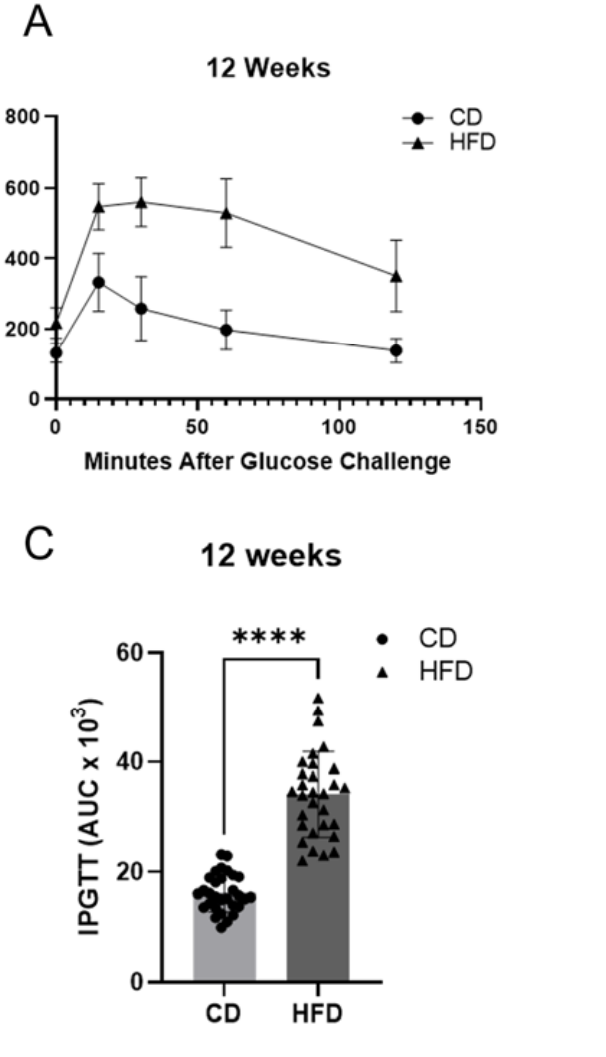
Figure 4. Effects of HFD and zinc supplementation on glucose tolerance. HFD induced increase in glucose tolerance was unaffected by zinc supplementation. Blood glucose levels in CD and HFD groups after IPGTT, performed ( A ) before zinc supplementation and ( B ) one week prior to sacrifice. ( C , D ) Integrated AUC was calculated showing higher changes in blood glucose levels in HFD groups. Data are reported as mean ± SD (n = 30 mice/group, A , C ; n = 14–15 mice/group, B , D ) with significance set to 0.05. *** p < 0.0004, **** p < 0.0001. CD = control diet, HFD = high fat diet, NZ = normal zinc, ZS = zinc supplement, IPGTT = intraperitoneal glucose tolerance test.